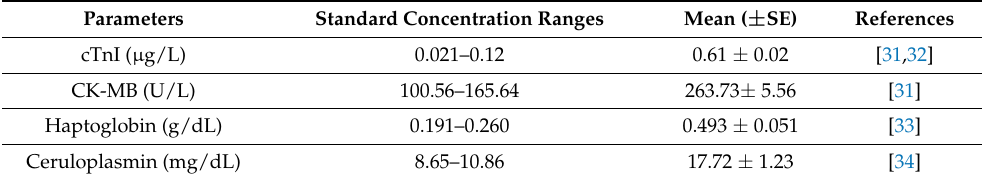
Table 2. The standard range and mean concentrations of the cardiac troponin I (cTnI), creatine phos-